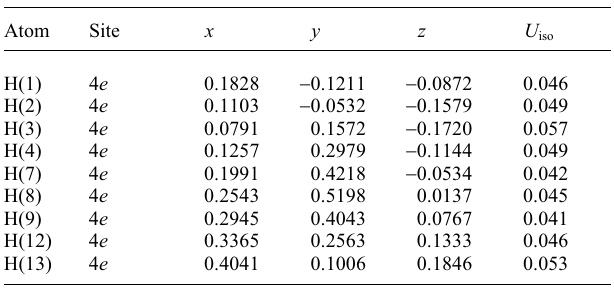
Table 3. Atomic coordinates and displacement parameters (in Å 2 ) .